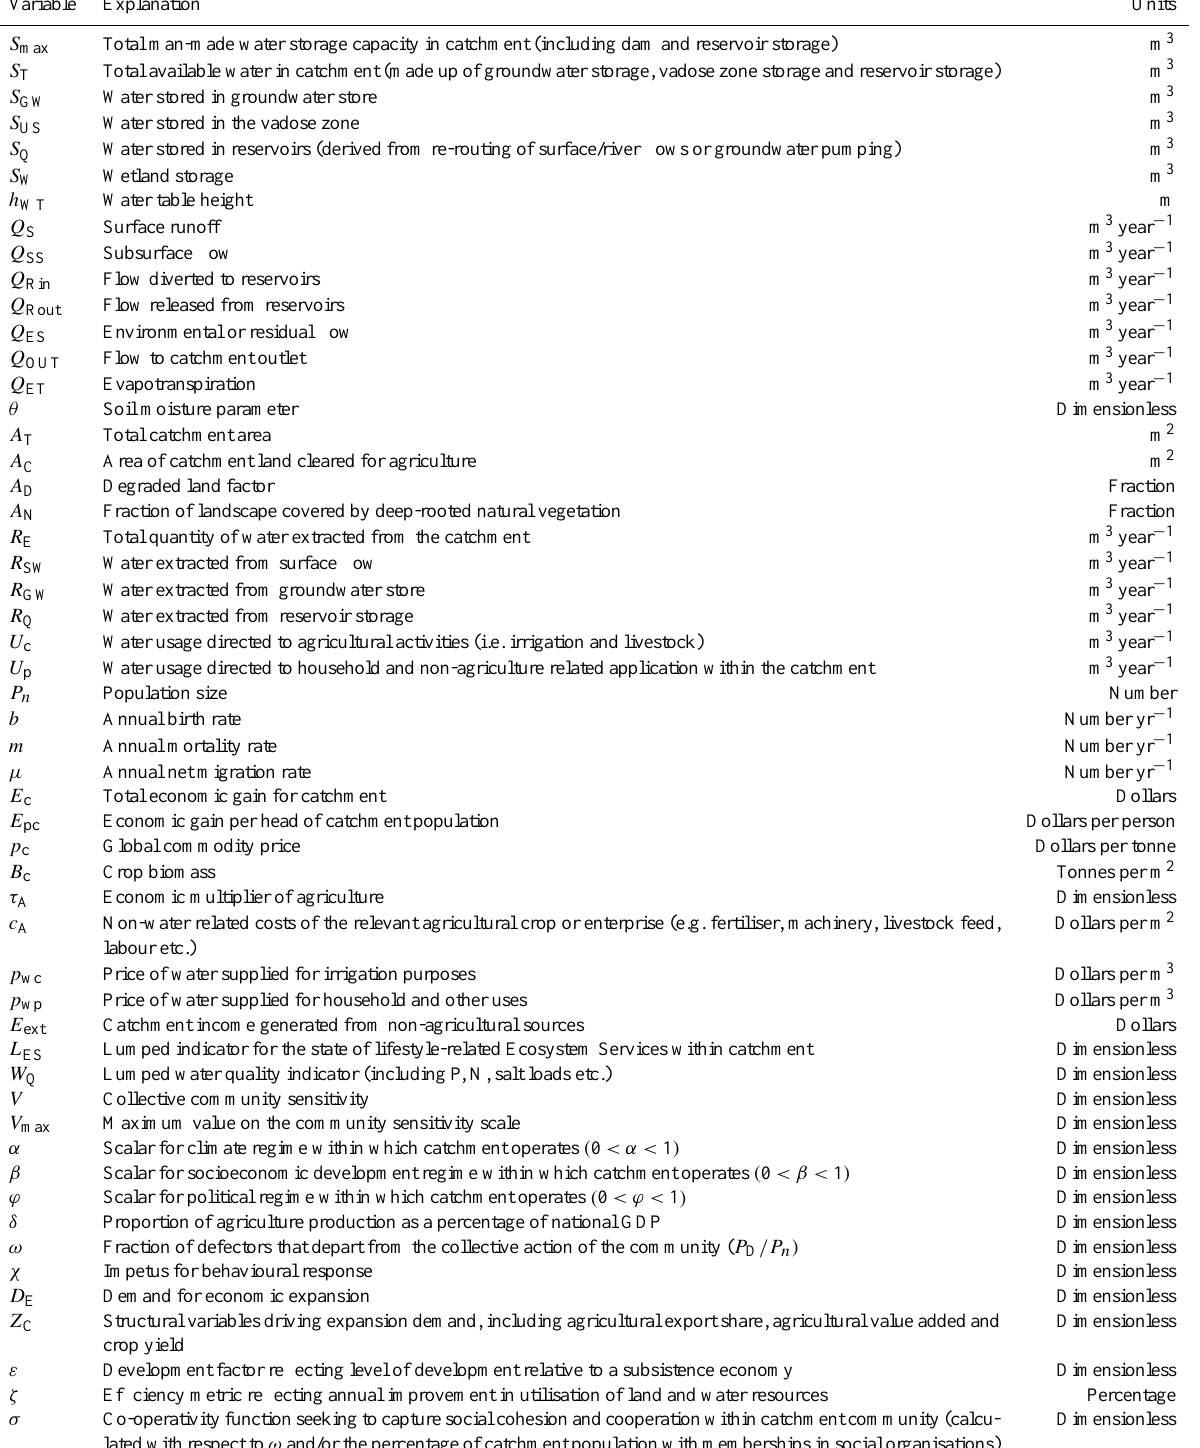
Table A1. Table of